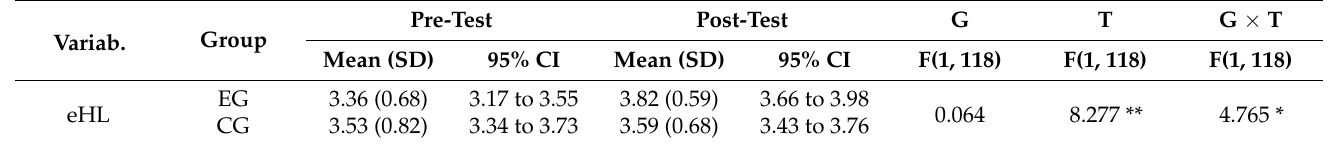
Table 3. Changes in eHealth literacy over the intervention.